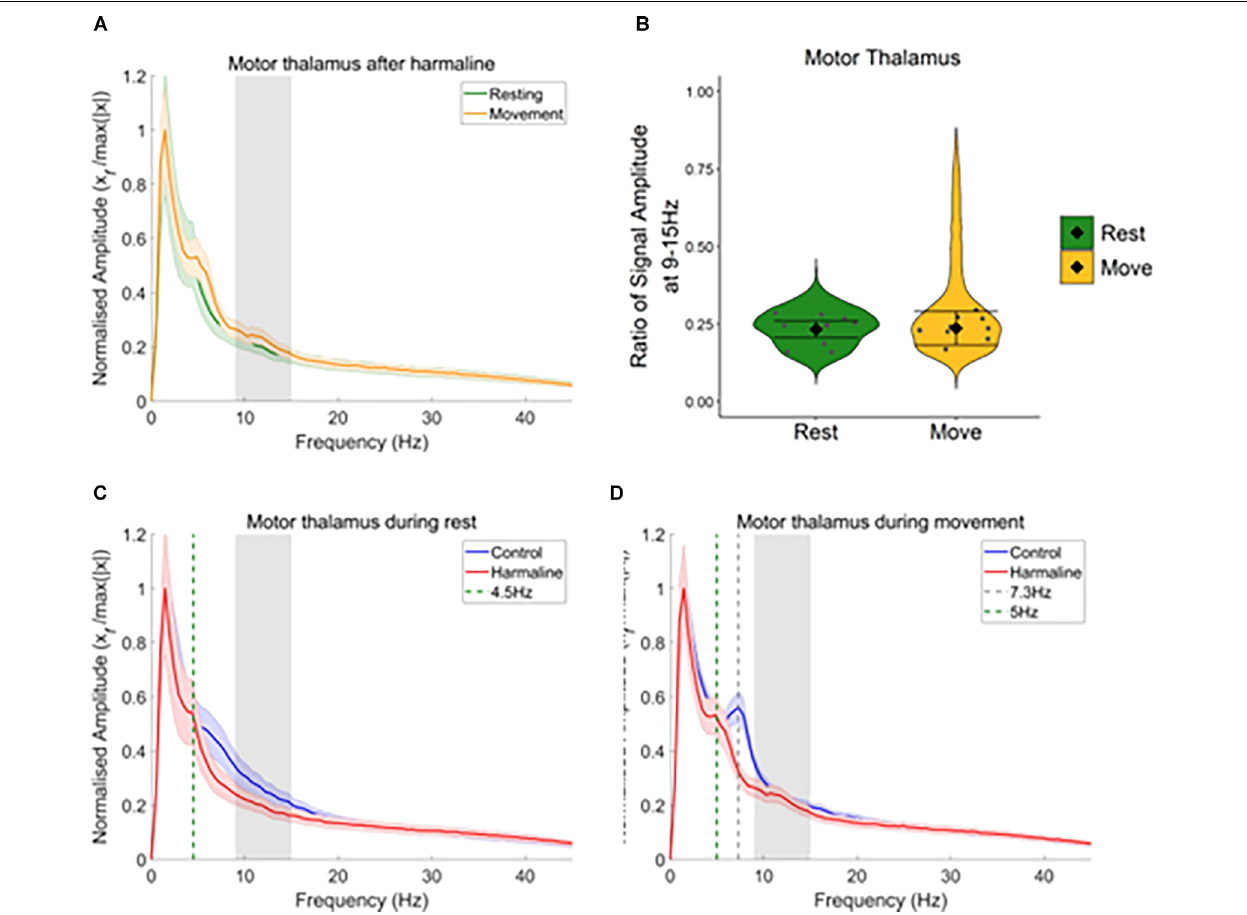
FIGURE 8 | Harmaline changes the frequency of thalamus rhythms during movement. (A) Mean ( ± SE) amplitude spectrum for the motor thalamus ( n = 9) during rest and movement during harmaline. The solid line represents mean amplitude, and the coloured shaded areas represent SE. The grey area represents the tremor frequency. (B) Ratio of amplitude at the tremor frequency range for the motor thalamus, where the violin plots show the distribution of this ratio across all epochs. Individual grey points represent the mean per rat. Fixed effects parameter estimates ( ± CI) representing predicted mean estimates are shown by (cid:7) and corresponding error bars. (C,D) Mean ( ± SE) amplitude spectrum for the motor thalamus ( n = 9) during (C) rest and (D) movement during control and harmaline. The solid line represents mean amplitude, and the coloured shaded areas represent SE. The grey area represents the tremor frequency.